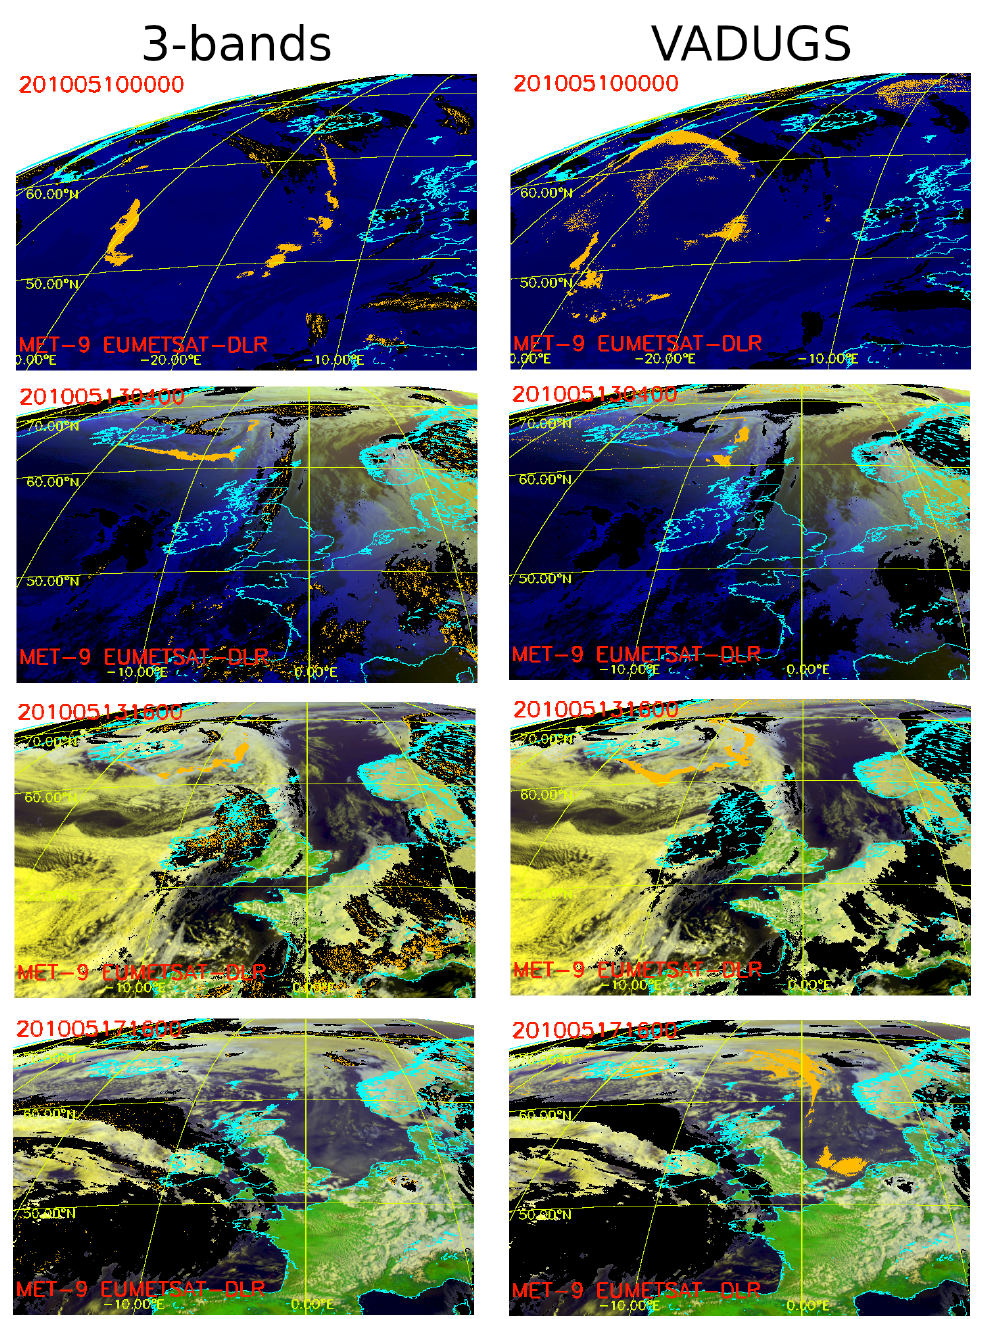
Figure 12. 3-bands and VADUGS retrievals of volcanic ash cover for four scenes of the Eyjafjallajökull eruption. The left column shows 3-bands volcanic ash masks in orange on top of a false colour RGB image, the right column shows VADUGS results. Black areas indicate the presence of ice clouds as obtained from COCS (see Sect. 4.3); however, ash detections inside ice clouds are not masked out as in Fig. 3 but shown on